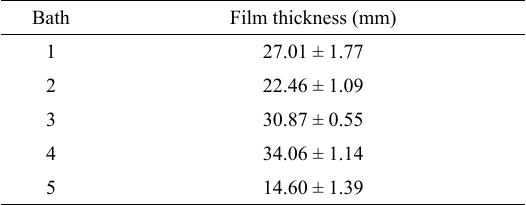
Table 3. Film thickness determined from SEM micrographs of cross-sections of films obtained in baths with different tungsten